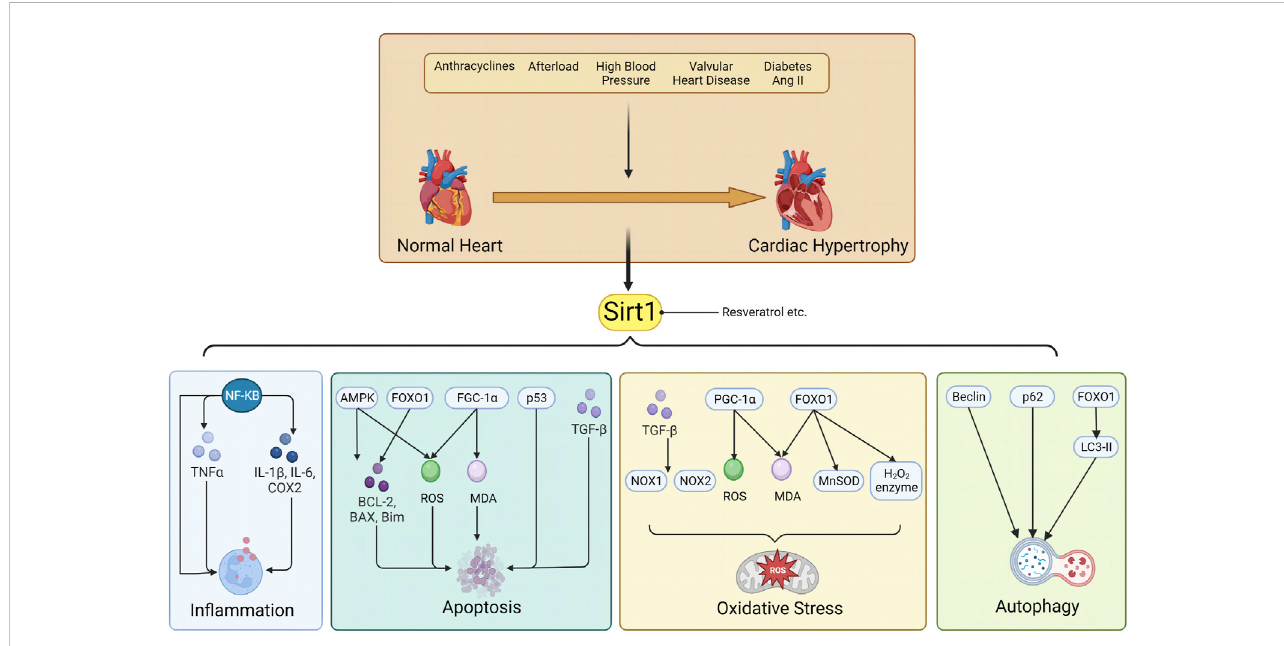
FIGURE 1 Sirt1 is involved in the pathological mechanism of myocardial remodeling through in fl ammation, apoptosis, oxidative stress and